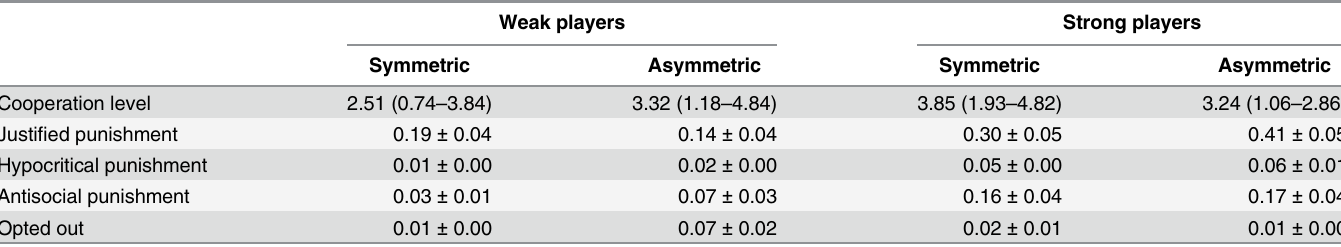
Table 2. Summary data for weak and strong